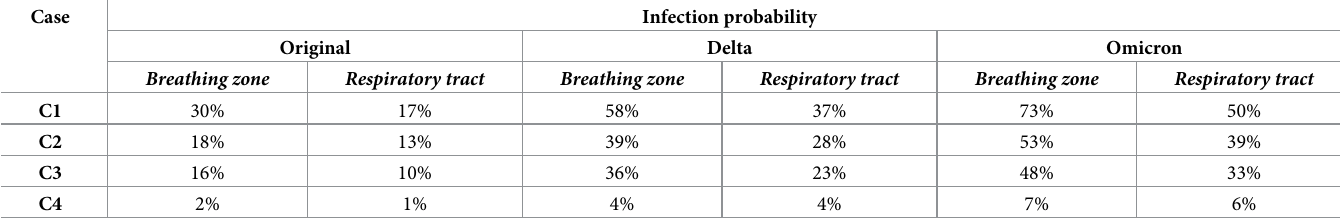
Table 2. Infection risk SARS-CoV-2 according to breathing zone residence and respiratory tract deposition.